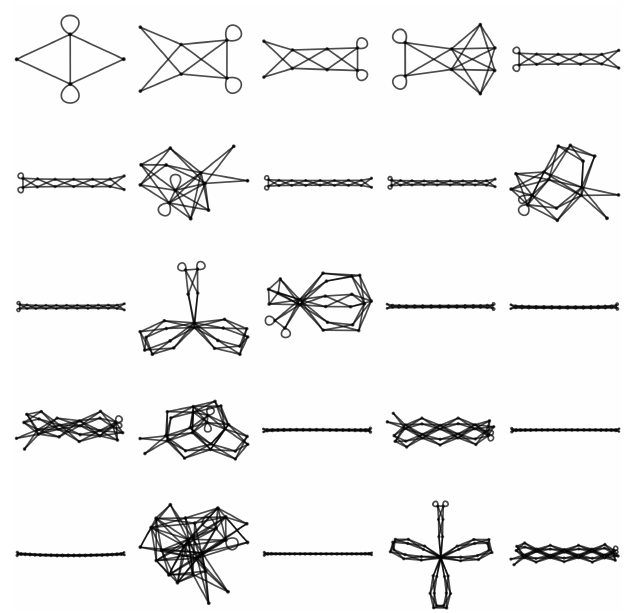
Figure 13. Antipodal condensed graphs, A p for p = 2 r for r = 3–51 (odds). Graphs corresponding to p = 2 times a prime are distinctively linearly in shape. Those corresponding to p = 2 times a prime square also hold their distinctive flower shape.